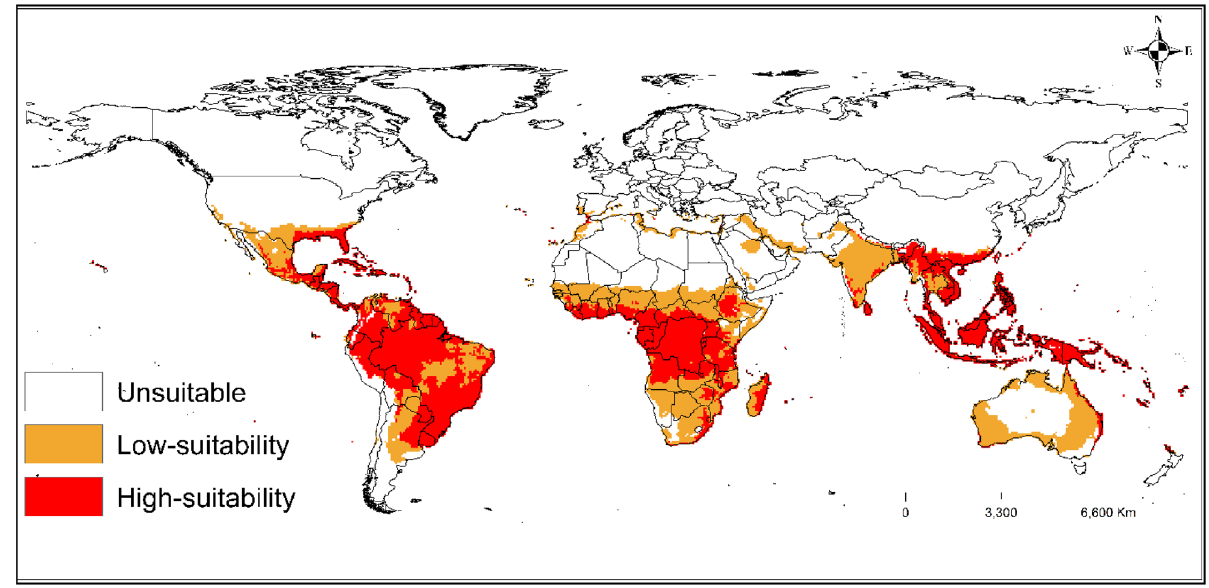
Figure 4. Ecoclimatic index (EI) for the occurrence of T. radiata at the current time , modelled using the CLIMEX model. Inadequate (if EI = 0), low suitability (when 0 < E I < 30), and high suitability (when 30 < EI < 100). ESRI ArcMap 10.2.2 (https:// suppo rt. esri. com/ en/ Produ cts/ Deskt op/ arcgis- deskt op/ arcmap/ 10-2- 2# downl oads) and CLIMEX 4.0.0 (https:// www. hearne. softw are/ Softw are/ CLIMEX- DYMEX/ Editi